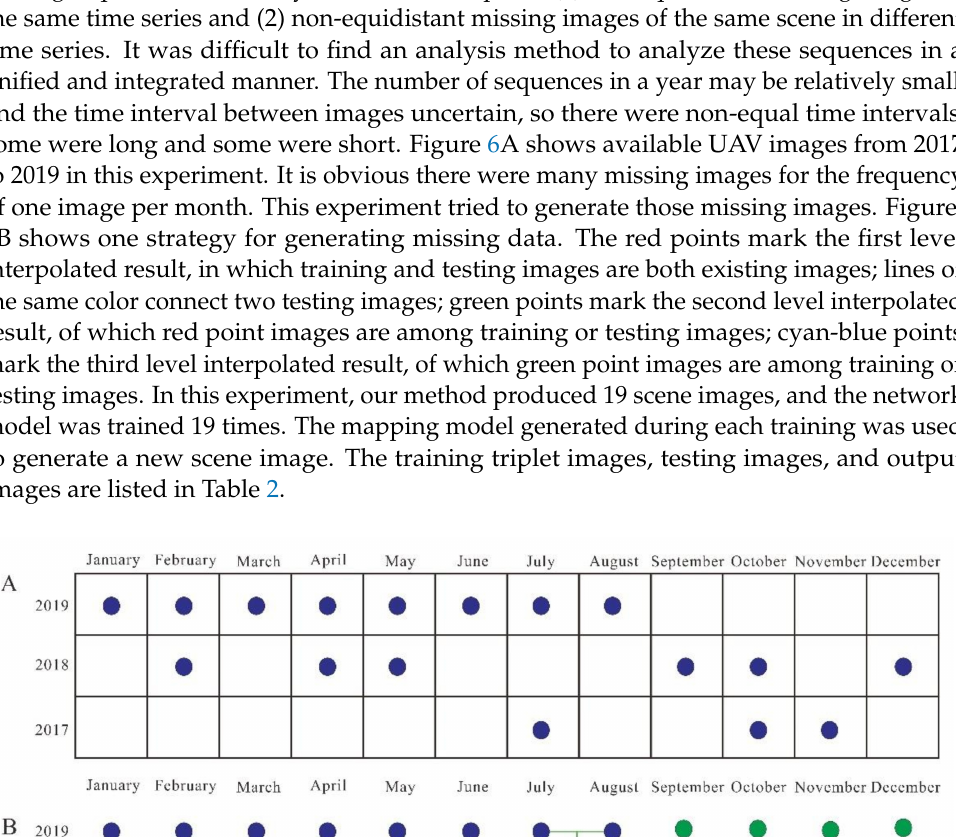
and I (cid:48) show visual effect of testing image). 5 4